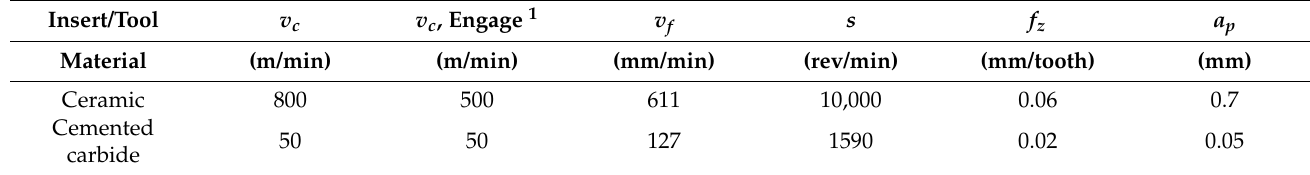
Figure 4. Definition of the cutting-edge motion in the material defining the direction of the up/centre/down mill part of the slot. Table 3. Machining settings used for the two types of machining operations.